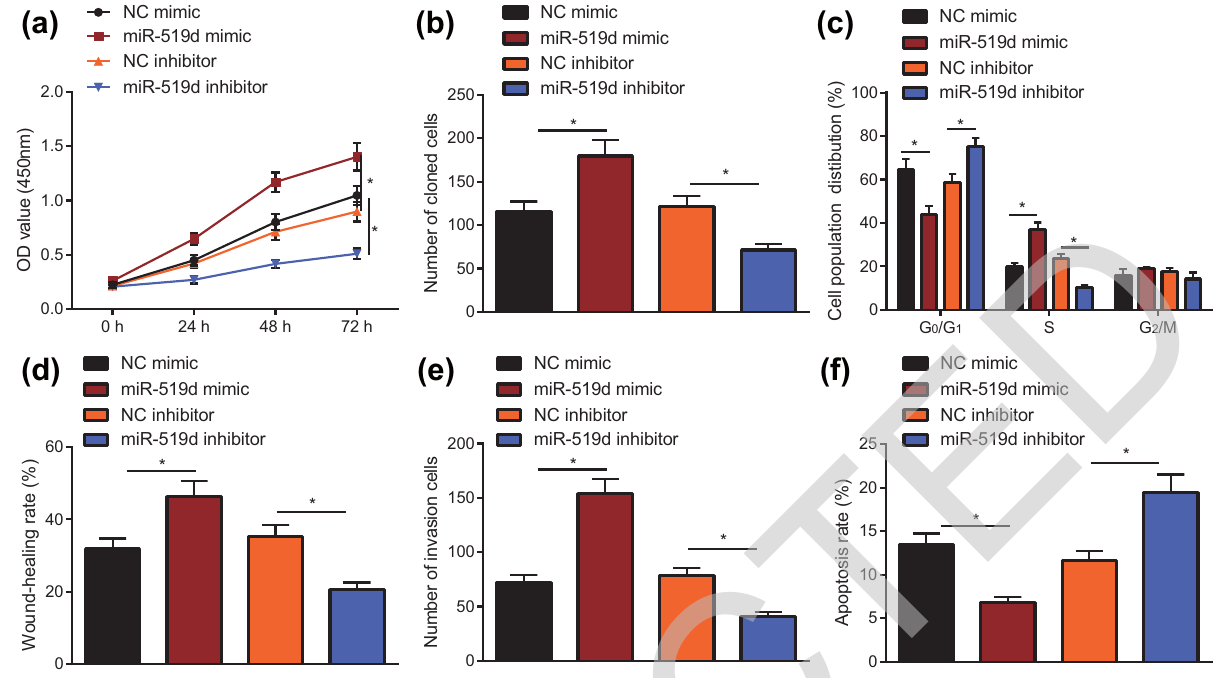
Figure 4: miR - 519d overexpression promotes the progression of HTR - 8/SVneo cells. ( a ) The proliferation of HTR - 8/SVneo cells after silencing miR - 519d or overexpressing miR - 519d by the CCK - 8 method; CCK - 8 assay was utilized to test the proliferation ability of HTR - 8/ SVneo cells when miR - 519d was overexpressed or silenced. ( b ) Clone formation assay was carried out to determine the cloning ability of HTR - 8/SVneo cells when miR - 519d was overexpressed or silenced. ( c ) Flow cytometry was applied to measure the cell cycle distribution of HTR - 8/SVneo cells when miR - 519d was overexpressed or silenced. ( d ) When miR - 519d was overexpressed or silenced, the migratory ability of HTR - 8/SVneo cells was measured using scratch test. ( e ) The invasion of the HTR - 8/SVneo cells was detected by the Transwell test, when miR - 519d was overexpressed or silenced. ( f ) HTR - 8/SVneo cells apoptosis was measured by fl ow cytometry, when miR - 519d was over - expressed or silenced; * indicates P < 0.05 ( the measurement data are shown as mean ± standard deviation, and di ff erences among groups were compared with one - way analysis of variance; Data at various time points were analyzed with two - factor analysis of variance, and the tests were repeated in triplicate )